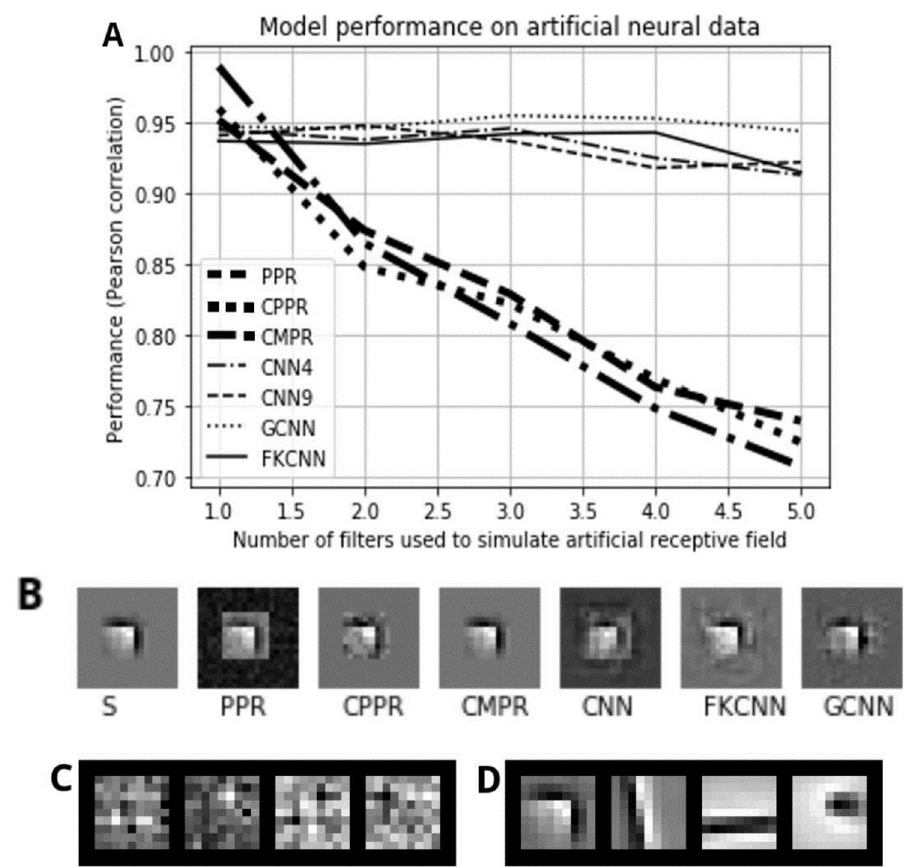
Fig 6. Model performance on artificial data. This figure shows the performance (A) and the recovered receptive fields (B-D) of the different methods. On the second row (B) from left to right, the seven images are the receptive field s recovered from each model type: PPR’s filter, CPPR’s filter, CMPR’s selection, CNN’s visualization, FKCNN’s visualization, and GaborCNN’s visualization. On the last row, the left images (C) are the learned kernels of the CNN. The right image (D) shows the top 4 highest-contribution kernels of the FKCNN model, whose importance scores are 0.782, 0.503, 0.469, and 0.391 respectively.